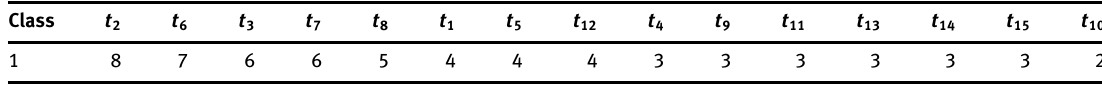
Table 4: Arranging ClassTermFrequency in Descending Order in Class 1.